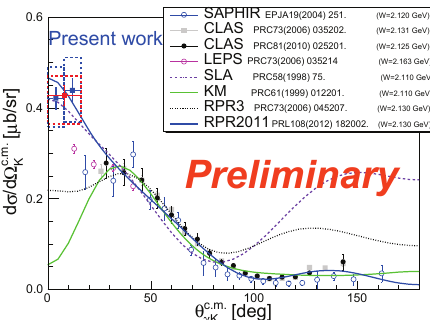
Figure 5. The θ c . m . dependency of the di ff er- γ K ential cross sections for the Σ 0 hyperon pro- duction. Our data is at Q 2 ∼ 0 . 5 (GeV / c ) 2 , the others are at Q 2 = 0 (see